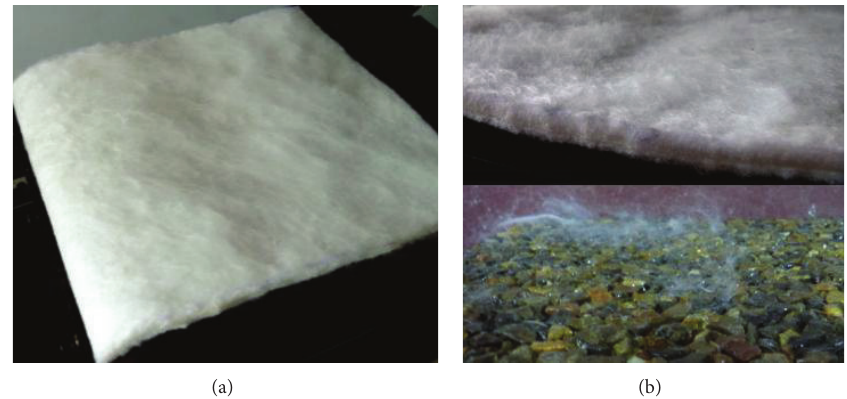
Figure 7: Ultimate surface state of CGM and PUR mixed crushed stones after testing.